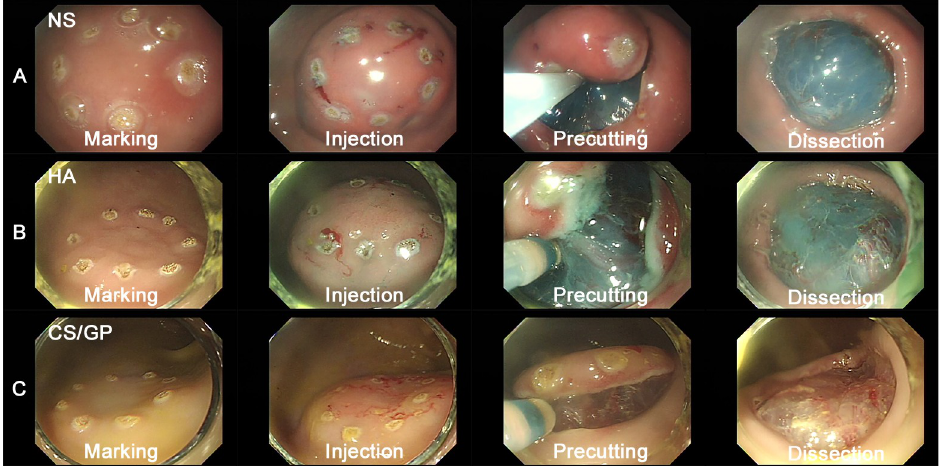
Fig 2. Endoscopic view of submucosal dissection procedure according to solution. (A) 0.9% normal saline (B) 0.4% hyaluronic acid (C) chitosan/ β -glycerophosphate (first row, marking; second row, injection; third row, precutting; fourth row,